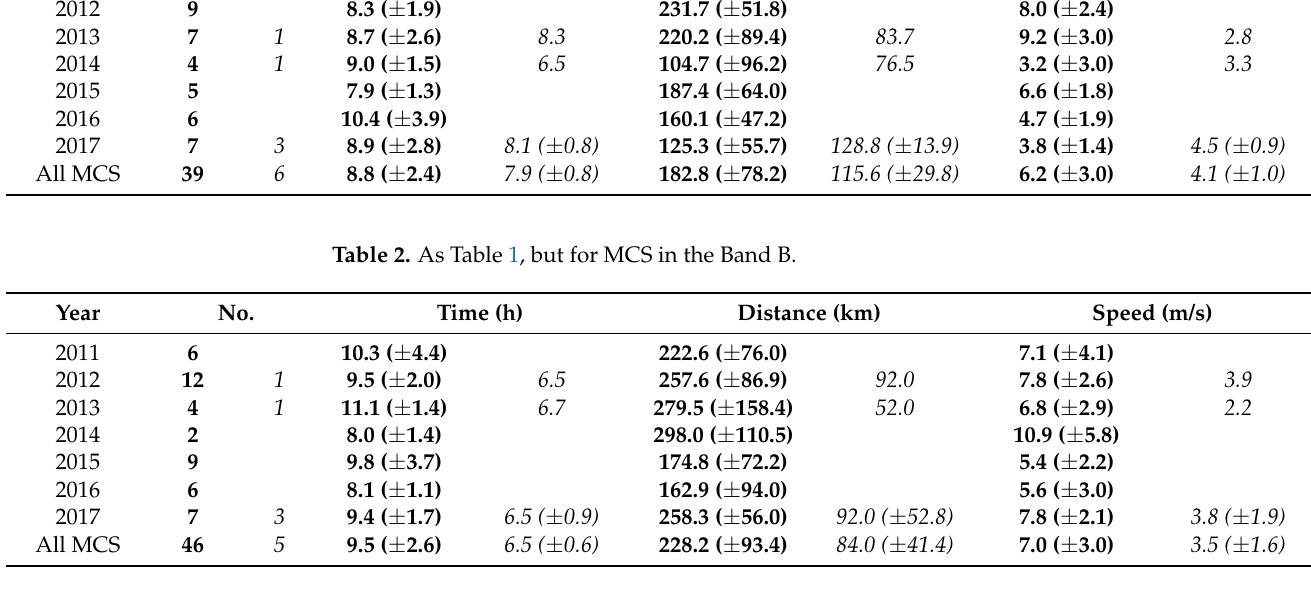
Table 3. As Table 1, but for MCS in the Band C.